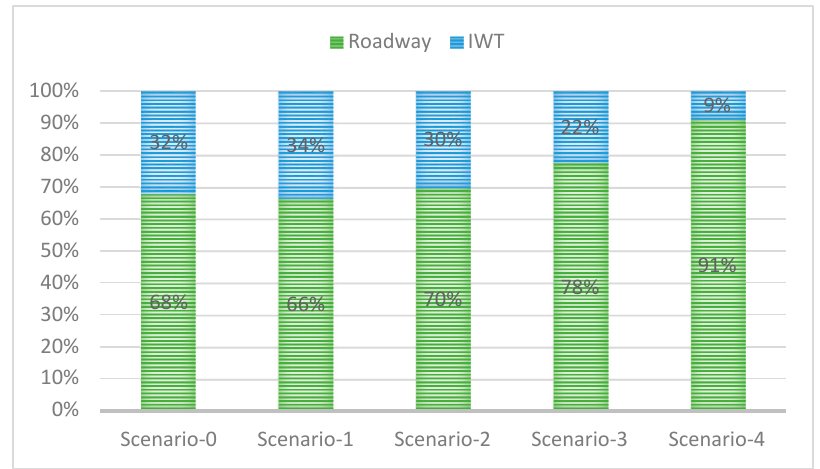
Figure 13. Proportion of transport modes from fruit garden to local collection hub.